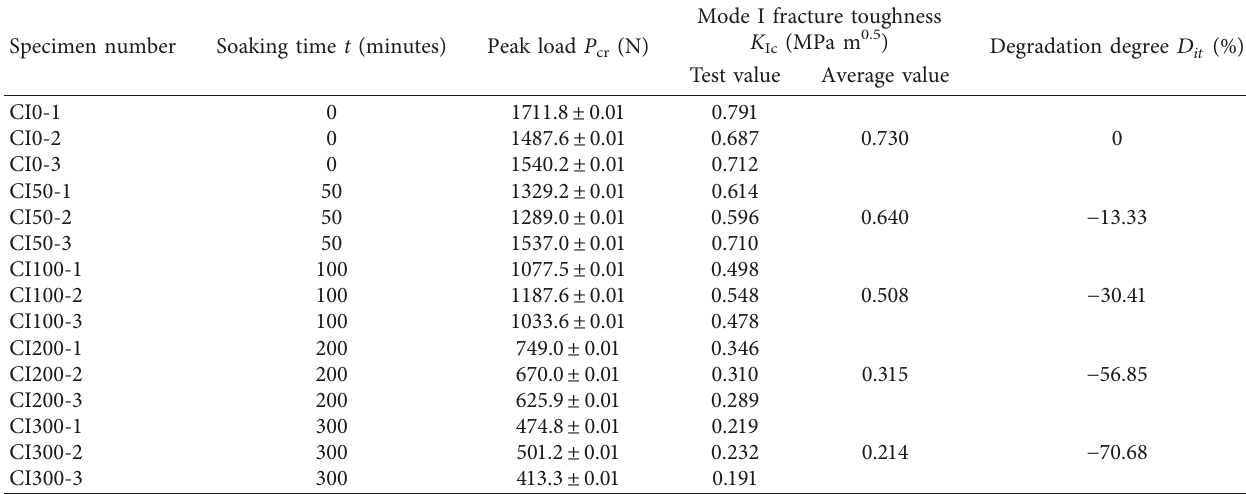
Table 4: Mode I fracture toughness of the Type C mudstone specimens for different soaking